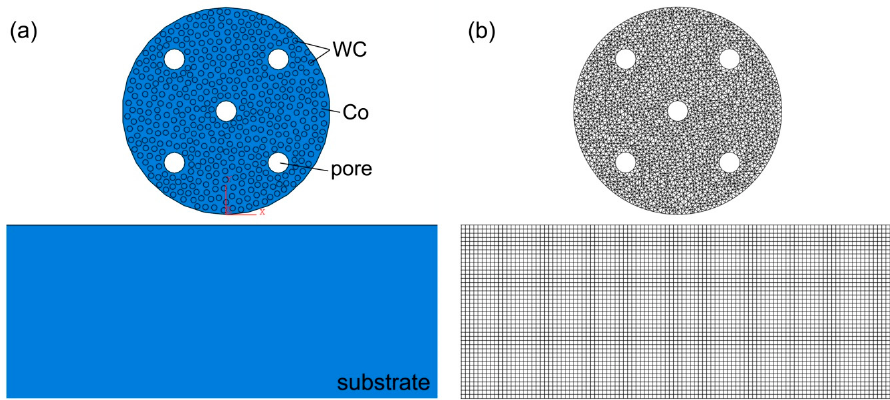
Figure 2. Geometry ( a ) and meshing ( b ) of the WC-Co particle used in the computation.